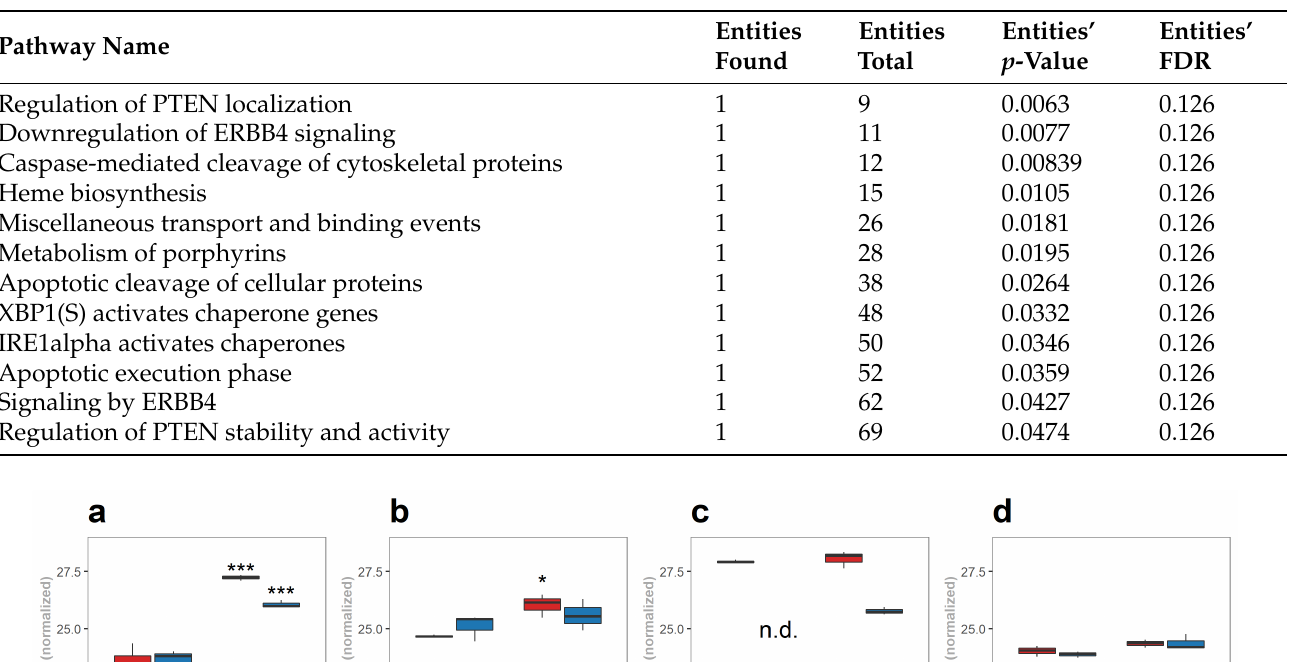
Table 4. List of pathways significantly connected to downregulated proteins. As an input for Reactome analysis, we used a list of all protein groups that were significantly changed (adj. p value < 0.05) between the control and sample in both conditions and downregulated (Log2FC < − 1). All pathways are listed; each entity’s p -value and FDR was calculated by the Reactome engine.